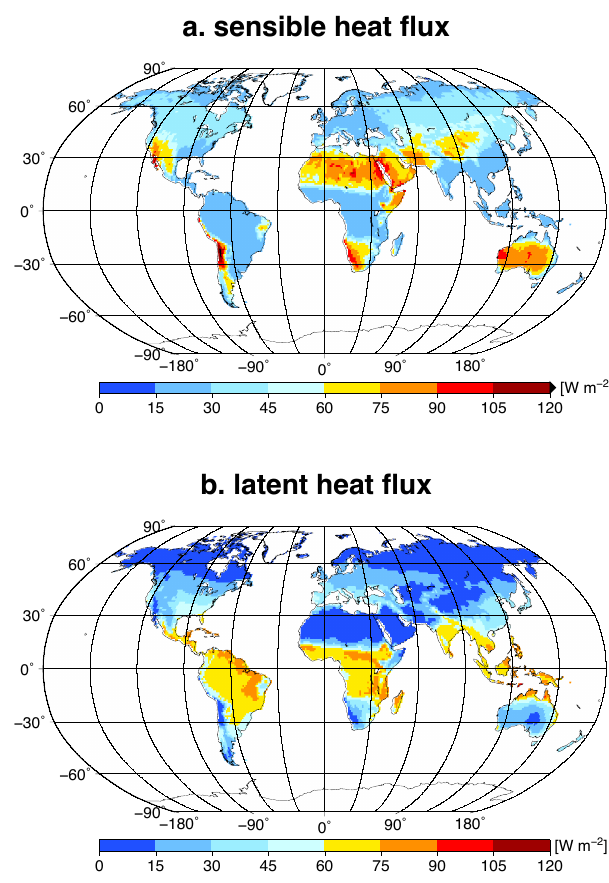
Figure 4. Partitioning of net radiation into (a) sensible, H opt , and Fig. 4. Partitioning of net radiation into (a.) sensible, H opt and (b) latent heat flux, λE opt , inferred from maximum power in the (b.) latent heat flux, λE opt , inferred from maximum power in the annual mean. Since net radiation at maximum power is R s / 2, its annual mean. Since net radiation at maximum power is R s / 2 , its spatial patterns corresponds to the variation of absorbed solar radi- spatial patterns corresponds to the variation of absorbed solar radi- ation shown in Fig. 3a. ation shown in Fig. 3a.